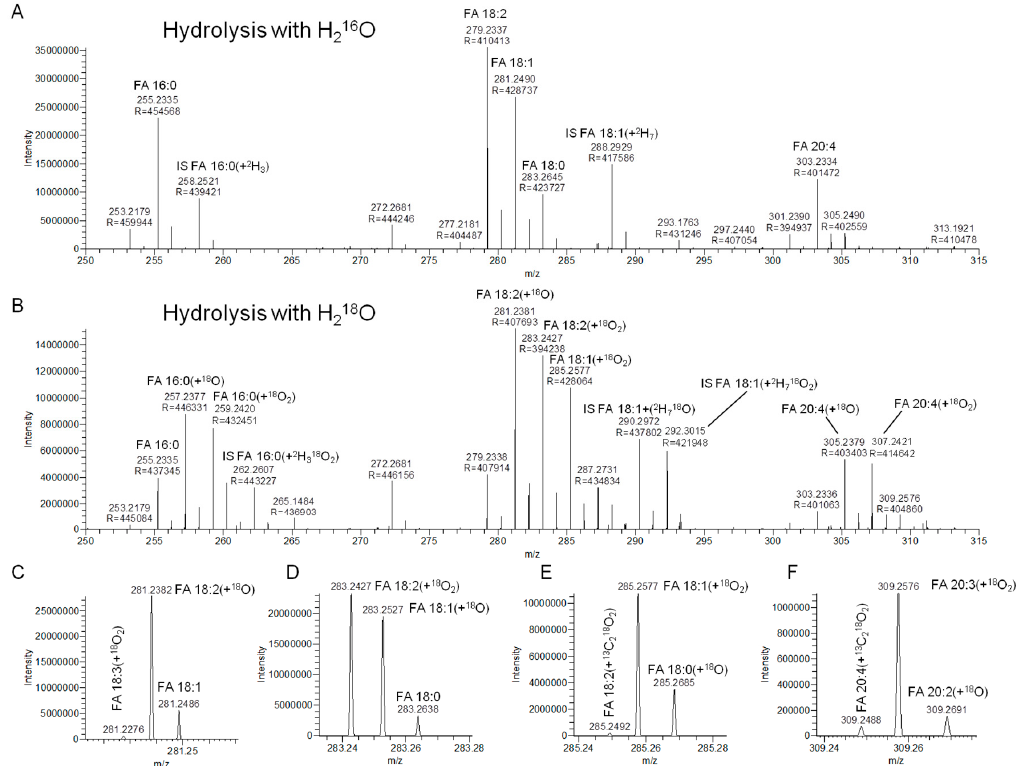
Figure 1. Detection of deprotonated fatty acyl (FA) analytes by 1 min of high resolution Fourier transform mass spectrometry (FTMS). ( A ) Negative ion mode FTMS spectrum of a total FA extract of human plasma using regular 16 O-rich H 2 O for acid-catalyzed hydrolysis. ( B ) Negative ion mode FTMS spectrum of a total FA extract of human plasma using 18 O-enriched H 2 O for acid-catalyzed hydrolysis. ( C–F ) Selected m/z intervals of the FTMS spectrum shown in B. These m/z intervals show baseline separation of deprotonated FA species with different numbers of double bonds, 18 O, 16 O, 13 C, 12 C, 2 H and 1 H atoms.